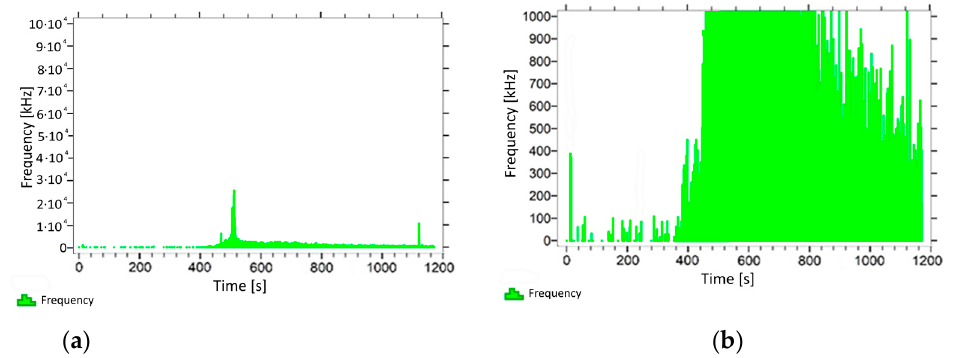
Figure 11. Graph of frequency distribution during the test for a representative sample from series P 10 : ( a ) considering the entire occurring frequency range and ( b ) with details about the frequency range before the moment of breakage.